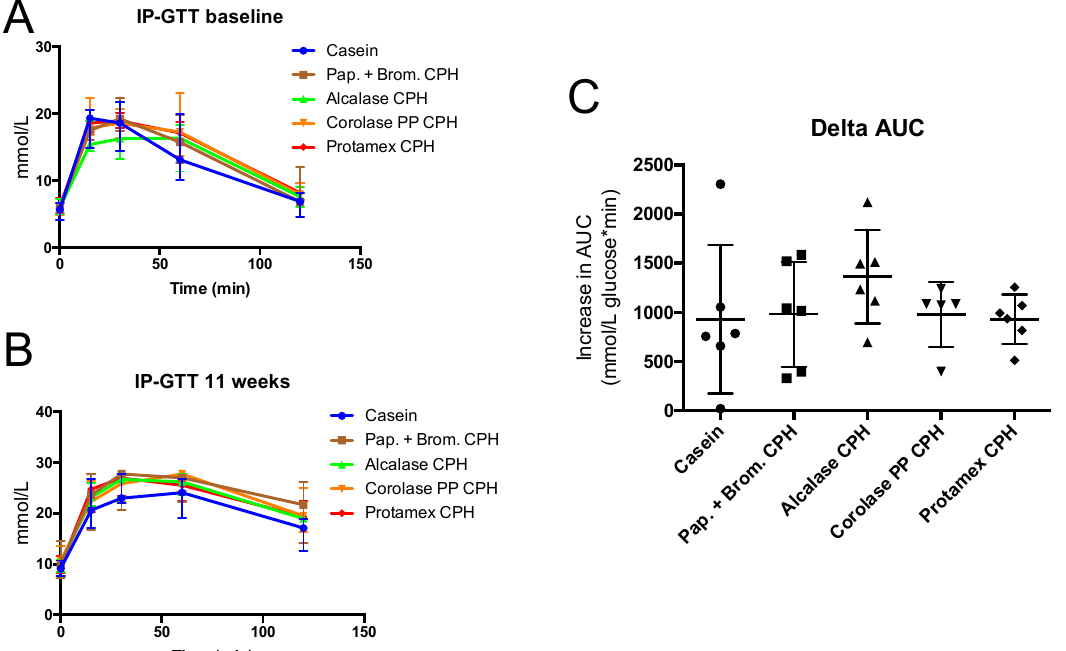
Figure 4. Intraperitoneal glucose tolerance (IP-GTT) in C57BL/6 mice at baseline ( A ) and after 11 weeks of feeding with 19 E% casein- or 9.5 E% casein and 9.5 E% CPH-high fat/high-sucrose diets ( B ). The increase in the area under the curve (AUC) from baseline to 11 weeks of feeding ( C ). Values are means with standard deviation ( n = 5–6). Significant difference between values were determined by one-way ANOVA with Fisher’s LSD test ( p < 0.05).